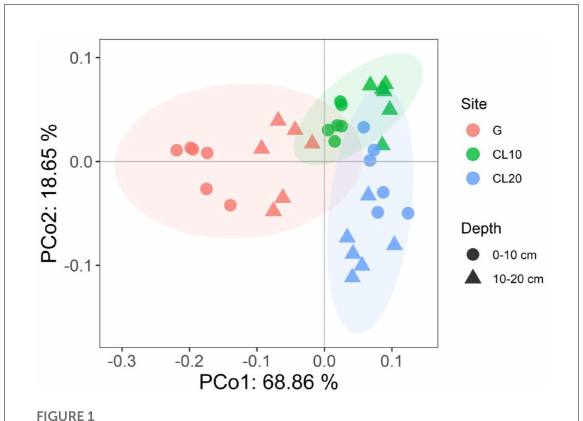
FIGURE 1 Principal co-ordinates analysis (PCoA) of soil properties among different land use types and